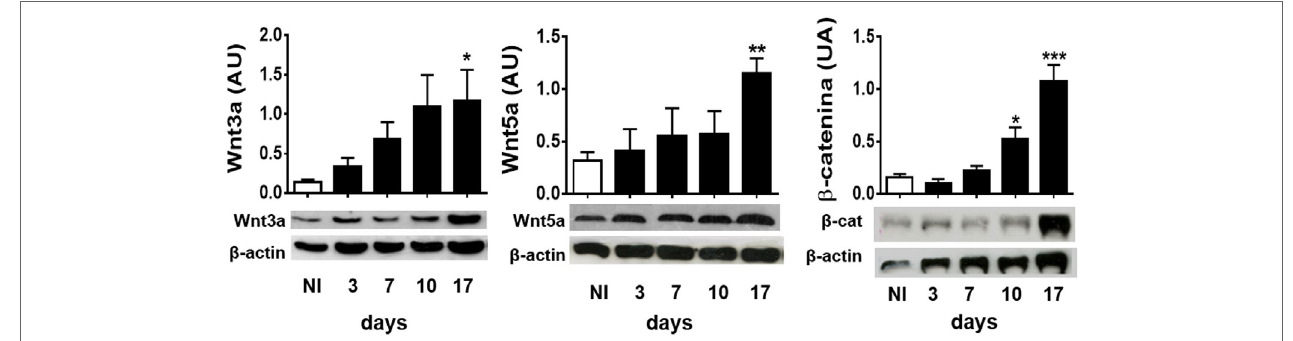
FigUre 1 | Experimental Trypanosoma cruzi infection induces the expression of Wnt pathway proteins. Western blot analysis of Wnt3a, Wnt5a, and β -catenin expression in spleen mononuclear cell homogenates derived from uninfected (NI) or T. cruzi -infected B6 mice at different times post-infection. Images show one representative NI and one infected mice by time point. Each bar represents the mean ± SEM of protein relative expression levels quantified by scanning the intensity of bands areas in the homogenates normalized to β -actin ( n = 5 mice per time point) (* P < 0.05; ** P < 0.01; and *** P <